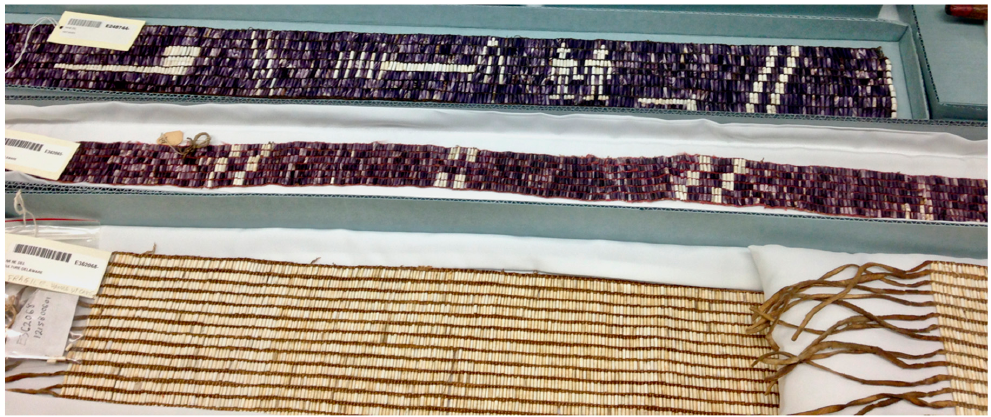
Figure 11. Wampum in the Smithsonian Institution National Museum of Natural History’s collections (cat no. E3052068, E362065, E248744). Photograph courtesy of the